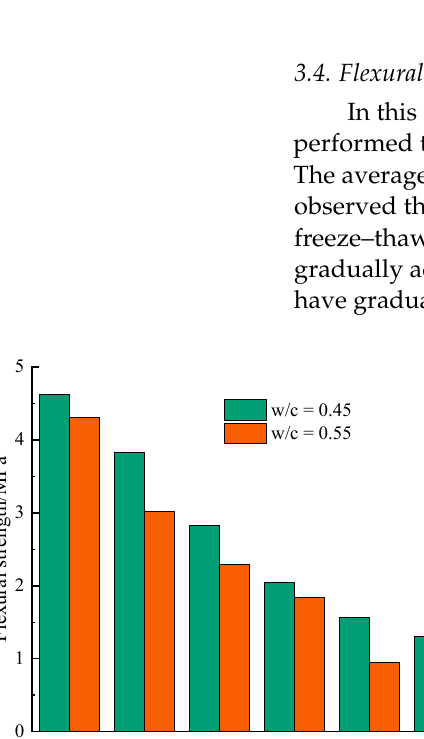
 Figure 13. Variation of dynamic increase factor (DIF) and strain rate. Table 2. Regress equations of the relationship between strain rate and DIF under different freeze–thaw cycles. Freeze–Thaw Cycles/N